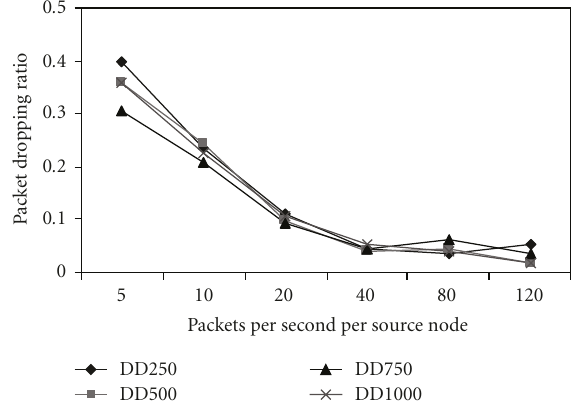
Figure 23: E ff ect of di ff erent DDNTs on the CA